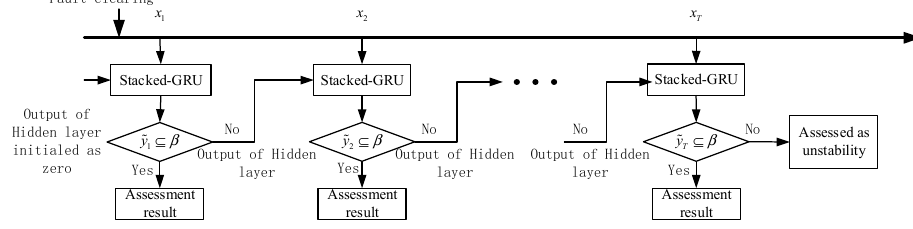
Figure 3. Online application of transient stability intelligent assessment.